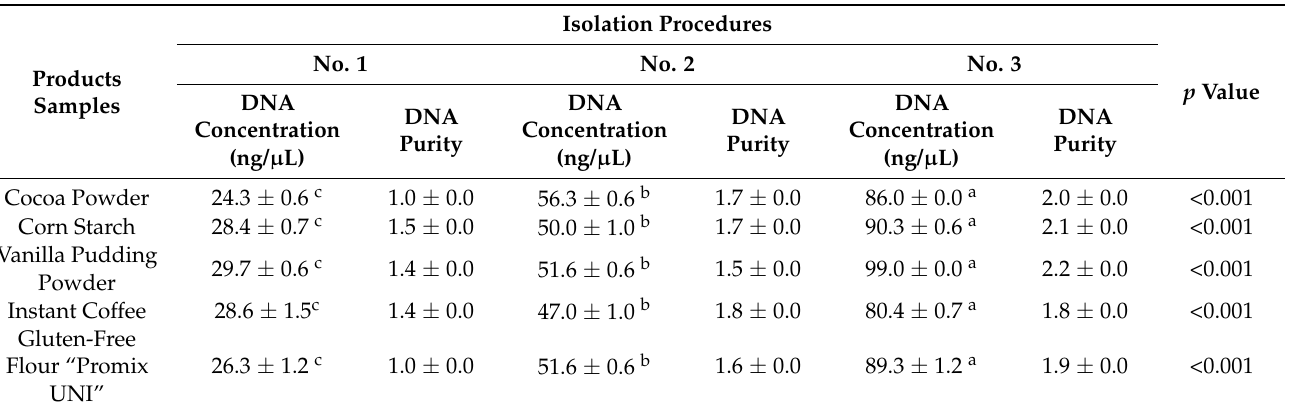
Table 2. Means and their standard deviations (SD) of the concentrations of isolated DNA samples from positive controls obtained by three isolation